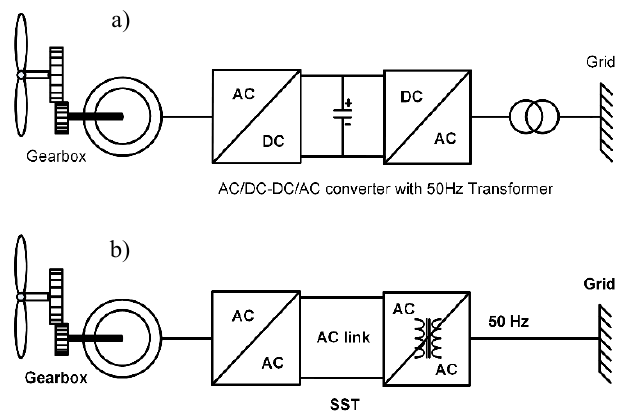
Figure 6. Integrating Type D synchronous generator to the grid: ( a ) typical; ( b ) using SSTs [54].